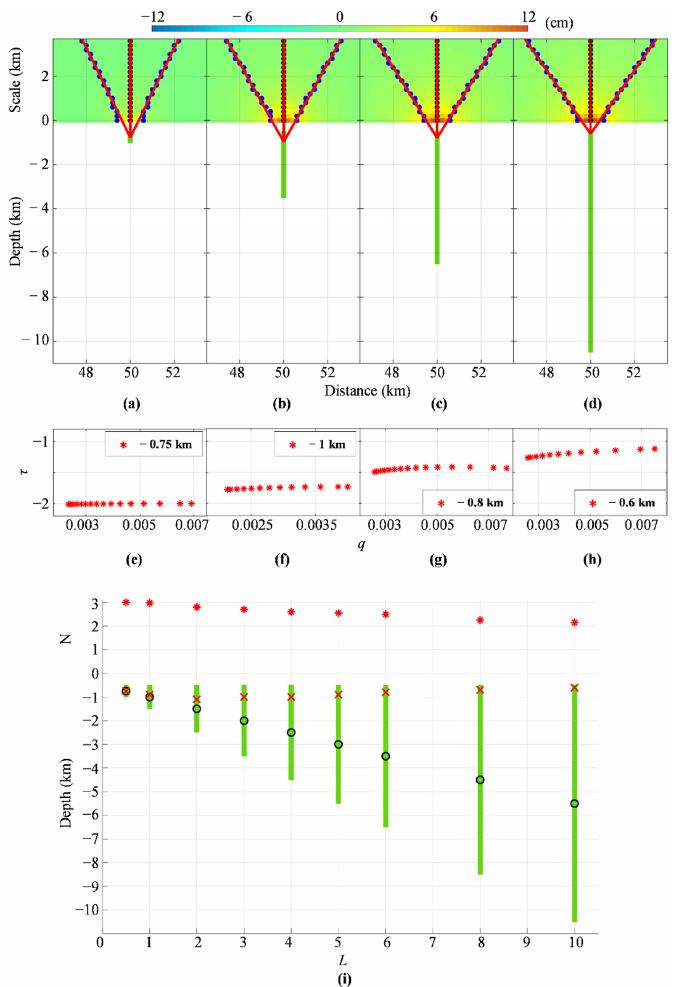
Figure 1. Vertical cylinder test. Multiscale methods applied to the vertical deformation generated by vertical cylinders with heights ( a , e ) L = 0.5 km, ( b , f ) L = 3 km, ( c , g ) L = 6 km, and ( d , h ) L = 10 km; vertical deformations are also shown at different scales z ; blue and black dots point out the zeros of vertical (subset I) and horizontal (subset II) derivatives of the analyzed dataset, respectively, while the red solid lines are the best fit regression lines; the vertical sections of the sources are represented in green; red stars indicate τ = ∂ log ( w )/ ∂ log ( z ) [ − ] in function of q = 1/ z [km − 1 ] using the source depth estimated by the Multiridge method, where w is the analyzed vertical deformation at the ridge subset II. ( i ) Multiscale results vs. L ; the black circles point out the source centers, while the red crosses and stars indicate the estimates obtained through the Multiridge and ScalFun methods, respectively.